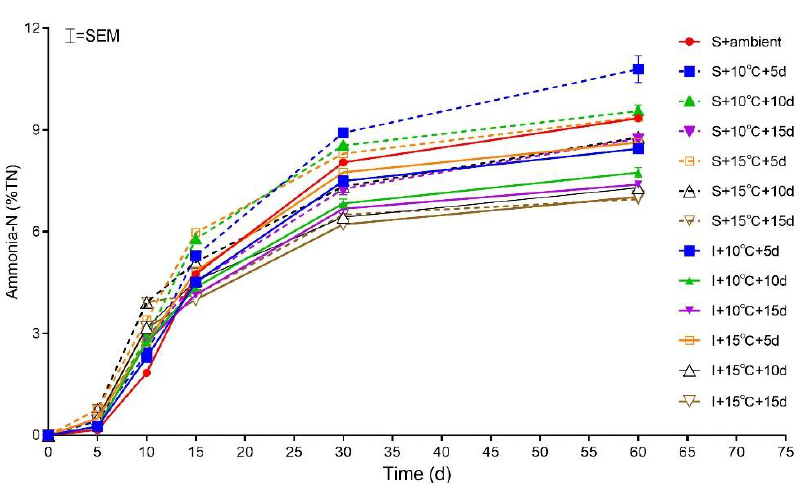
Figure 2. Dynamics of lactic acid, acetic acid, propionic acid and butyric acid in silage inoculated with inherent LAB (I) and commercial LAB (S) and stored at ambient temperature and stage-in- creased temperatures of 10 °C and 15 °C for 5, 10 and 15 days, respectively.